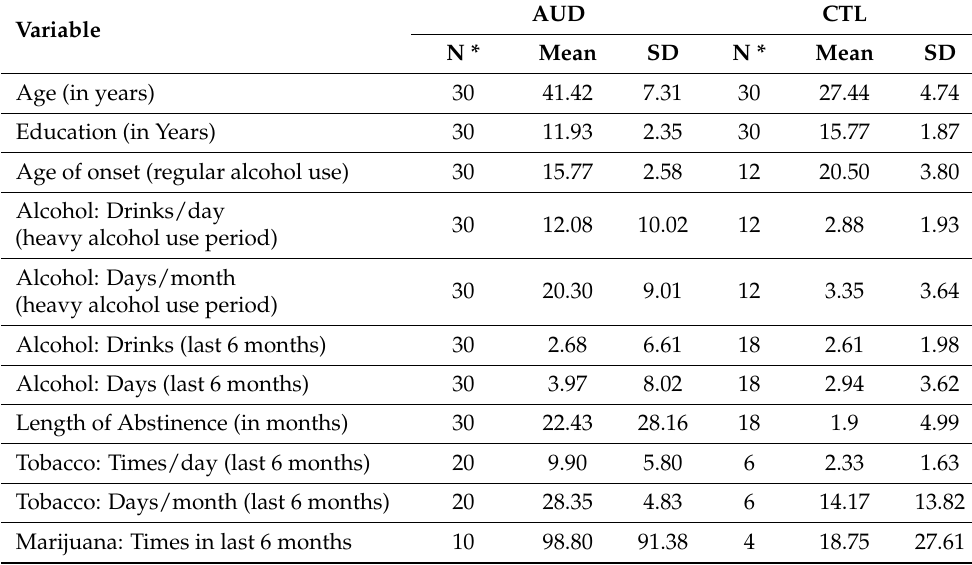
Table 1. Demographic and clinical characteristics of the